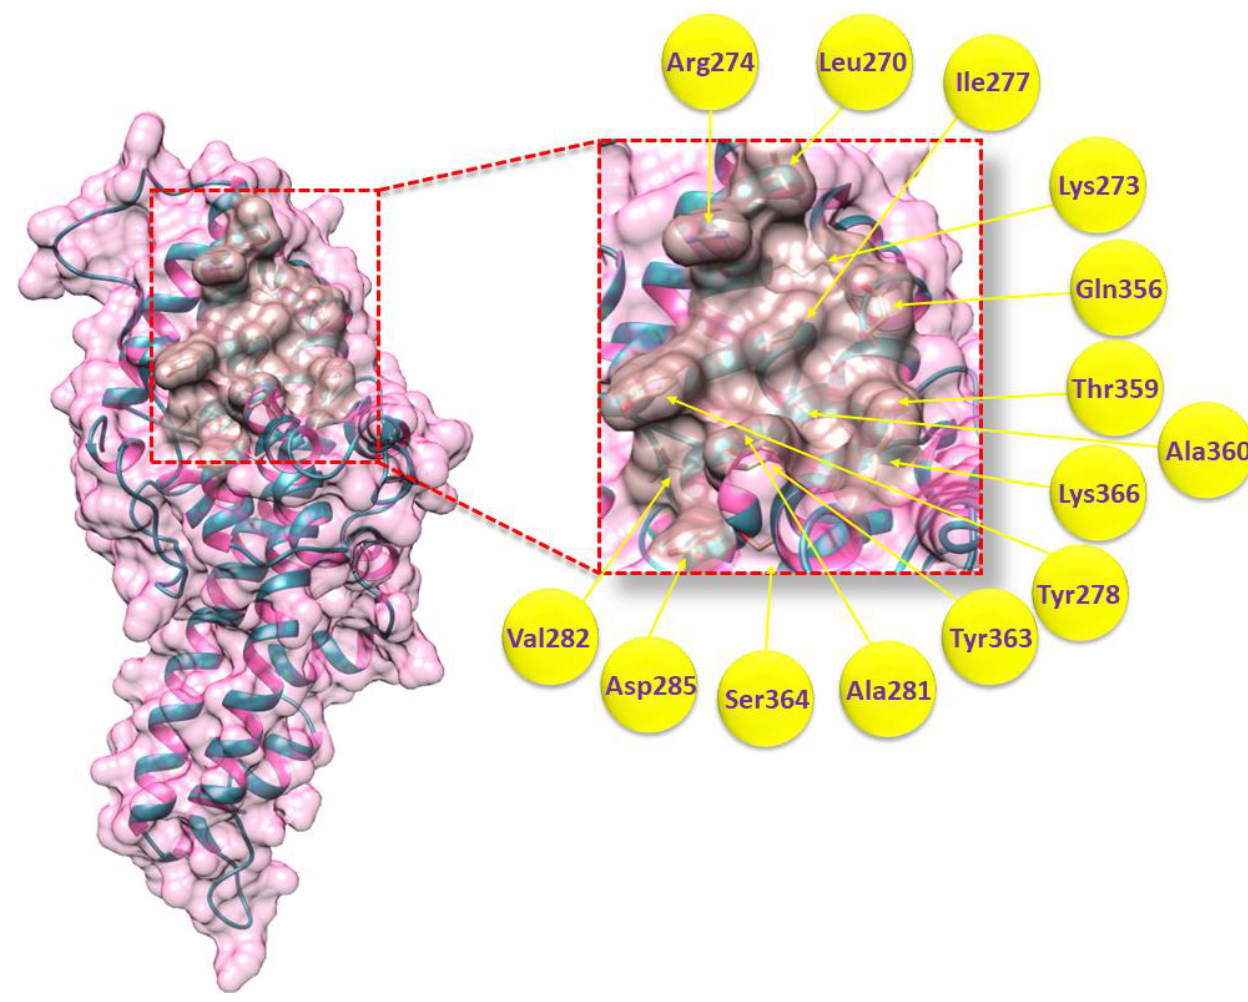
Figure 3. DBP ’ s binding pocket surface is emphasized in rosy brown color, whereas the rest of the protein surface appears pink. The ribbon color is dark cyan, while the interiors of the ribbon helix are identified with a hot pink tint. Furthermore, binding site residues that participate in the DBP–DARC complex are labeled with their amino acid number based on their position in the active binding site of the protein.